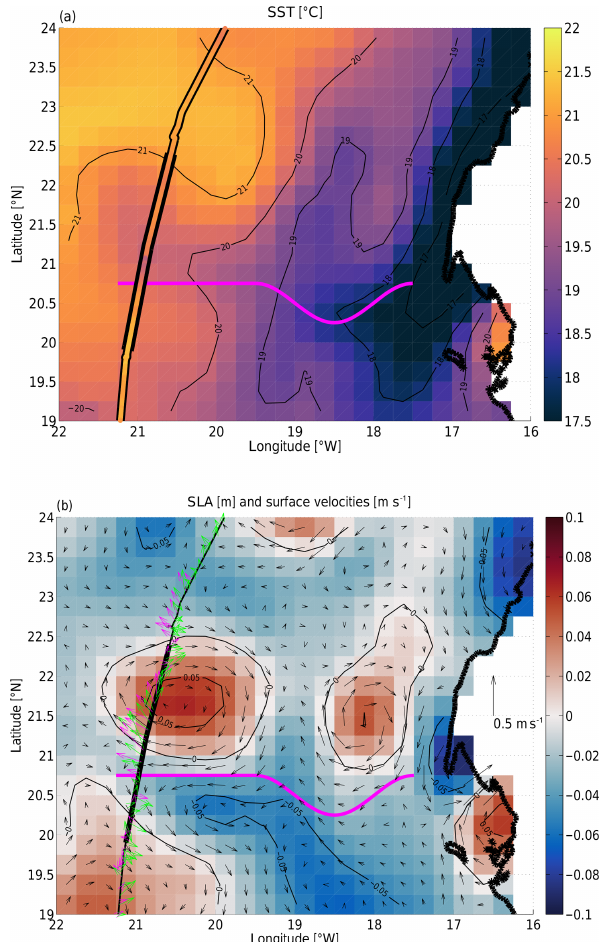
Figure 2. Maps of satellite-based (a) sea surface temperature (in degrees Celsius; NOAA OI SST V2) and (b) sea level anomaly (in meters; SSALTO/DUACS SSH L4). Both SST and SLA are nominal from 31 May 2018, i.e., during the TRIAXUS tow. The African coast is plotted black around 17 ◦ W. The ship track around 21 ◦ W is shown in black, and in (a) , data from the thermosalino- graph are plotted between the black lines. The thick part of the track lines shows the towed section presented here. Panel (b) also shows geostrophic velocities (in meters per second) in black with a 0.5ms − 1 scale bar shown on the right over land. Green and ma- genta arrows plot the VMADCP/WaMoS-measured velocities in 51 and 0m depth, respectively. The thick magenta line in both figures approximates the westward advection pathway discussed in the